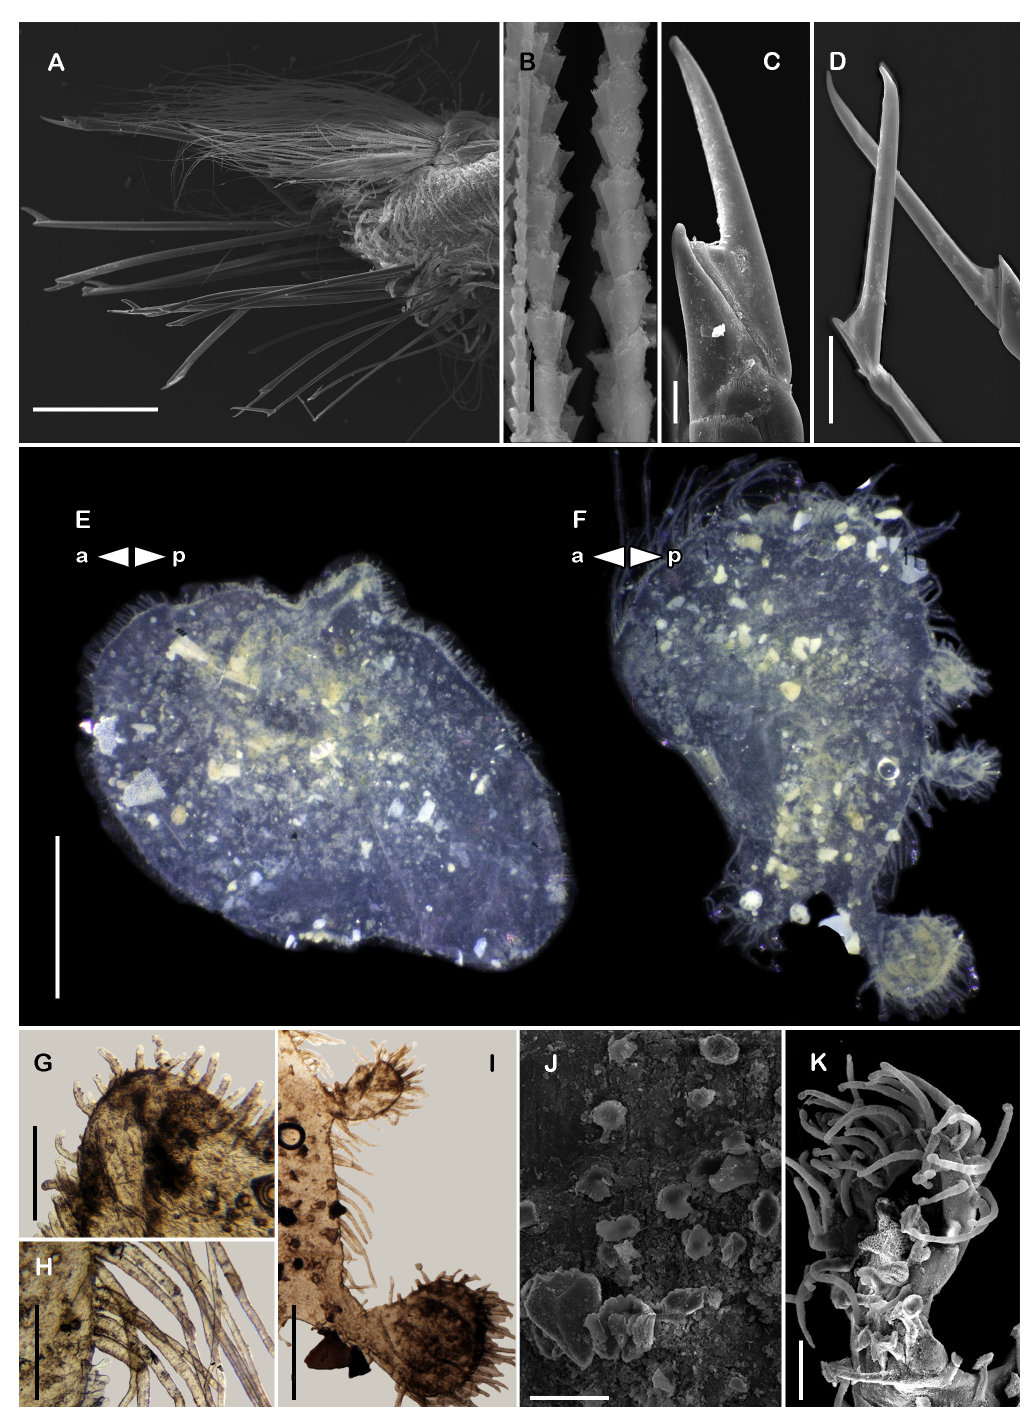
Fig. 16. Pelogenia hartmanae Pettibone, 1997, non-type material (UMML 7101-1369). A–D, J–K. SEM micrographs. A . Right parapodium from segment 25. B . Notochaeta from same. C . Unit A. D . Unit D. E . First right elytron. F . Posterior elytron. G . Distal expansion from E. H . Margin from F. I . Posterior process from F. J . Surface of posterior elytron with flat papillae and pedunculate papillae with flat tips. K . Posterior process, long dendritic papillae and pedunculate papillae with flat tip. Abbreviations: a = anterior; p = posterior. Scale bars: A = 500 μm; B = 10 μm; C = 20 μm; D, J = 50 μm; E–F = 1 mm; G–I, K = 100